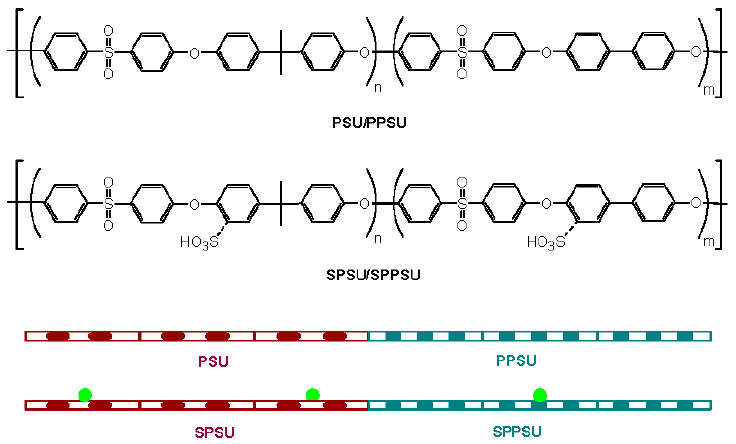
Figure 1. Chemical structure and schematic representation of polysulfone/polyphenylsulfone (PSU/PPSU) and sulfonated polysulfone / polyphenylsulfone (SPSU/SPPSU) copolymers. Sulfonic groups are represented by green circles.